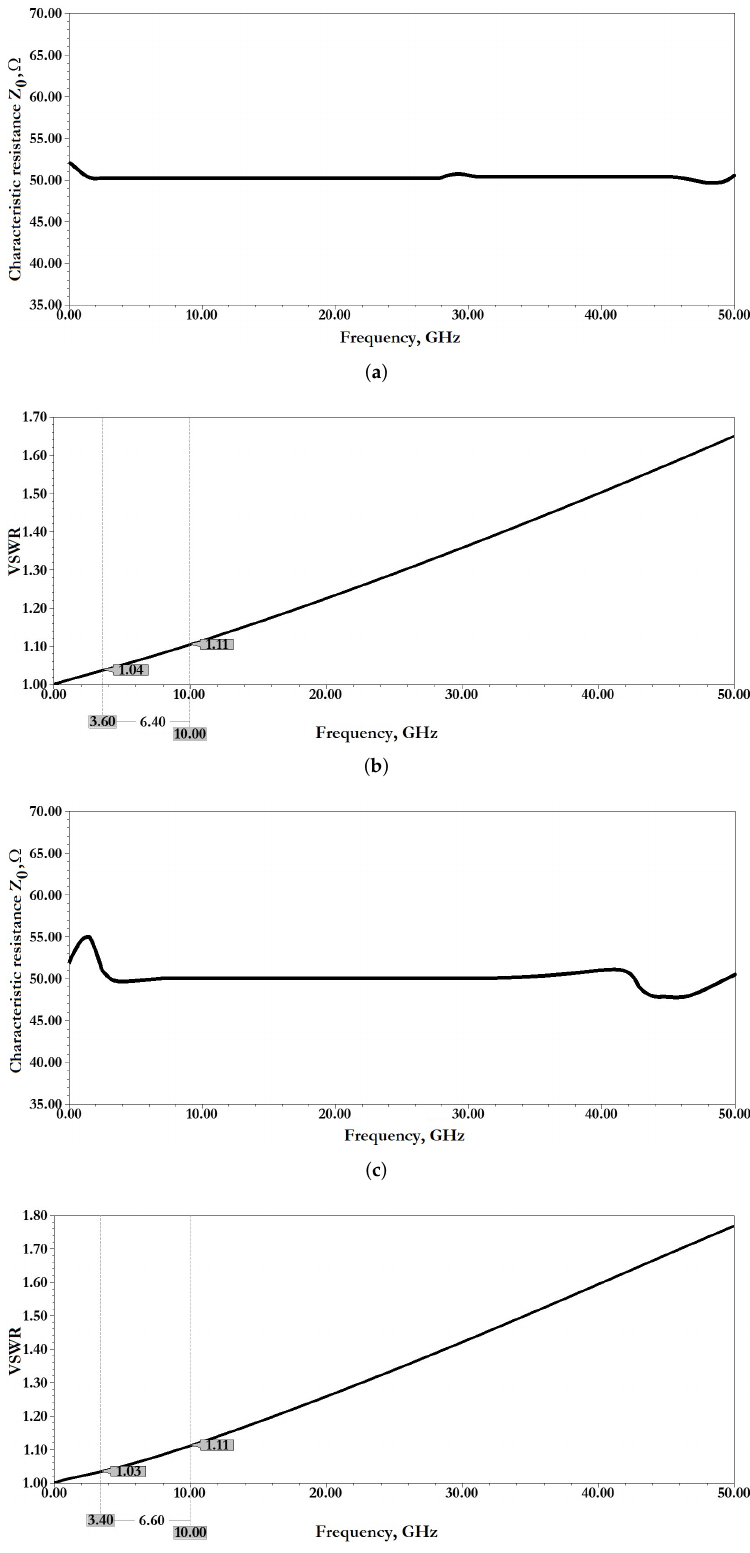
Figure 10. Distribution graph of CPW (A) and CPW (B) from the frequency RF signal: ( a , b ) the characteristic resistance Z 0 and the VSWR of CPW (A); ( c , d ) the characteristic resistance Z 0 and the VSWR of CPW